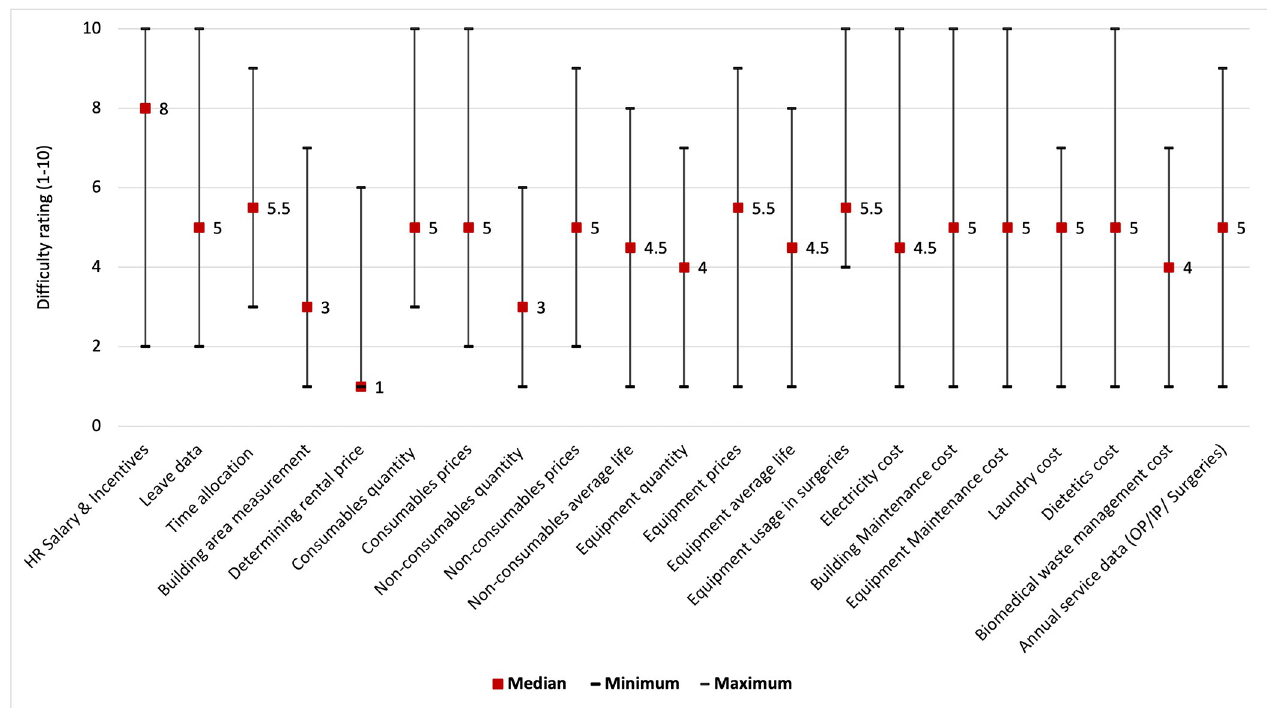
Fig 4. Difficulty rating � (1–10) for different input resources during cost data